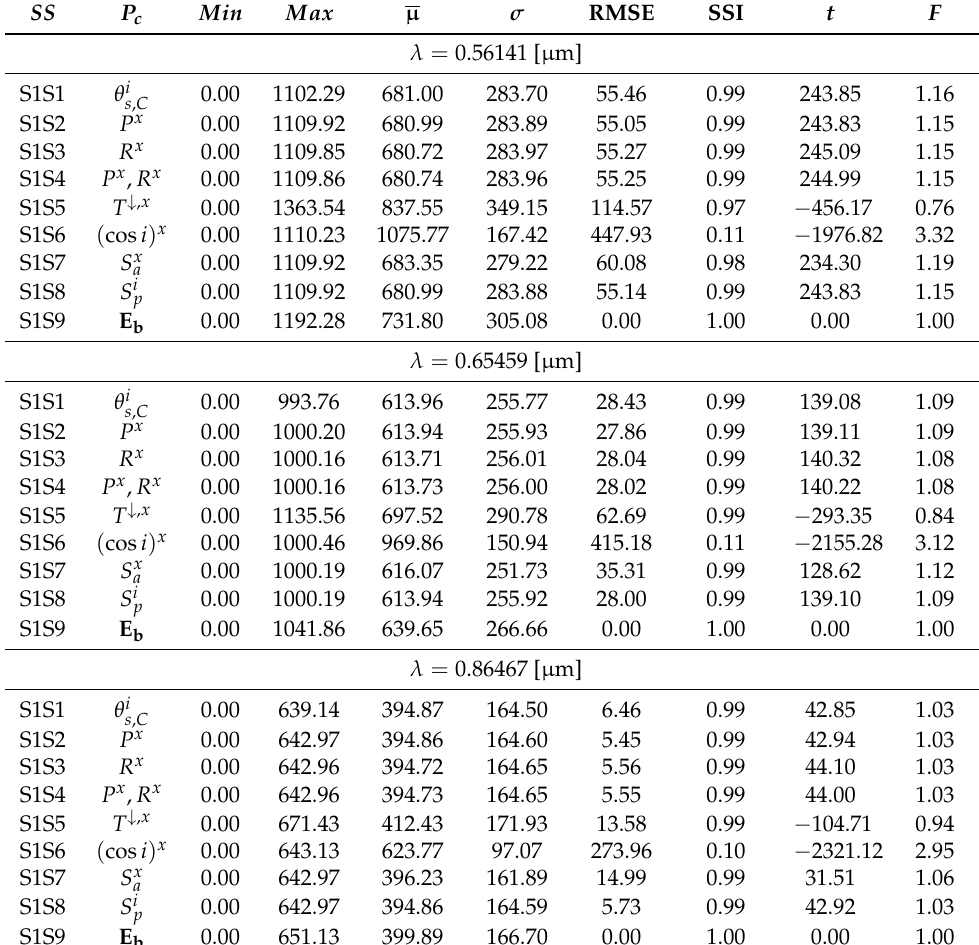
Table 4. Simulation and control scenario (SS) statistical results for direct irradiance. Control parameters ( P c ) for a scenario were included ( i ) or excluded ( x ) for comparison to a more fully comprehensive parameterization scheme ( E b ). Statistical parameter symbols include the